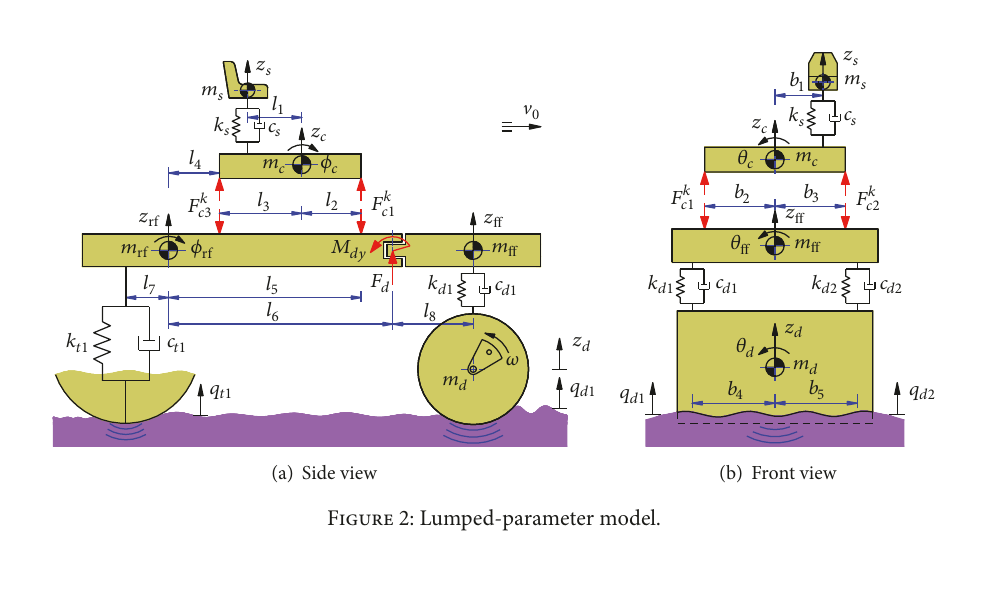
Figure 2: Lumped-parameter